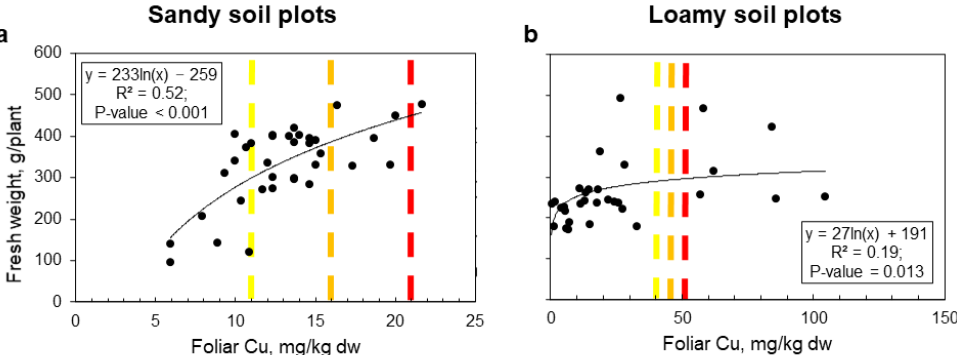
Figure 4. Scatterplot between the fresh weight of lettuce and the Cu concentration in leaves, in the sandy soil plots ( a ), and the loamy soil plots ( b ). Dashed lines represent the theoretical phytotoxicity thresholds for foliar Cu according to Verdejo et al., 2015 [43]; yellow = EC 10 , orange = EC 25 , and red = EC 50